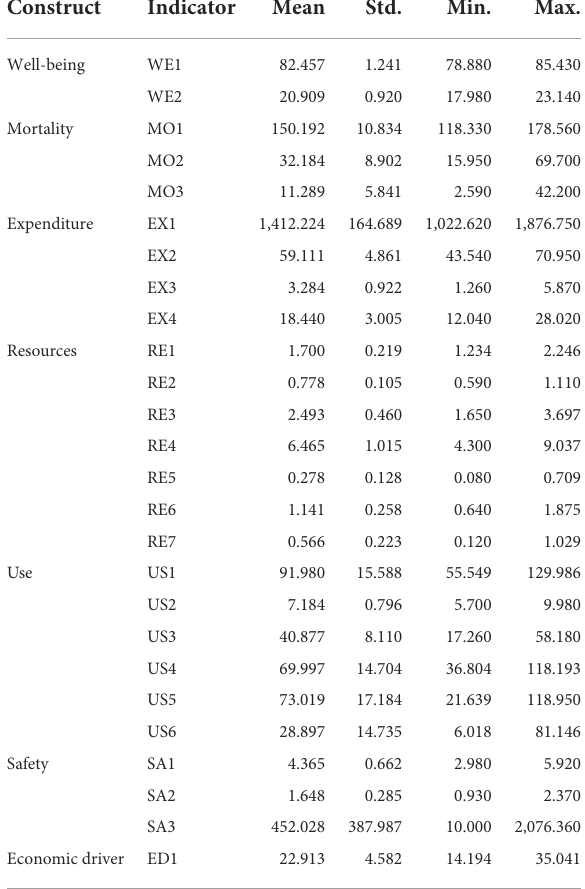
Table 4 includes the data corresponding to the assessment of the structural measurement model of the constructs estimated in formative mode (mode B). As can be seen, there are no multicollinearity problems (VIF < 5), and all indicators were kept in the model since those whose weights were not significant did exhibit significant loads (97,